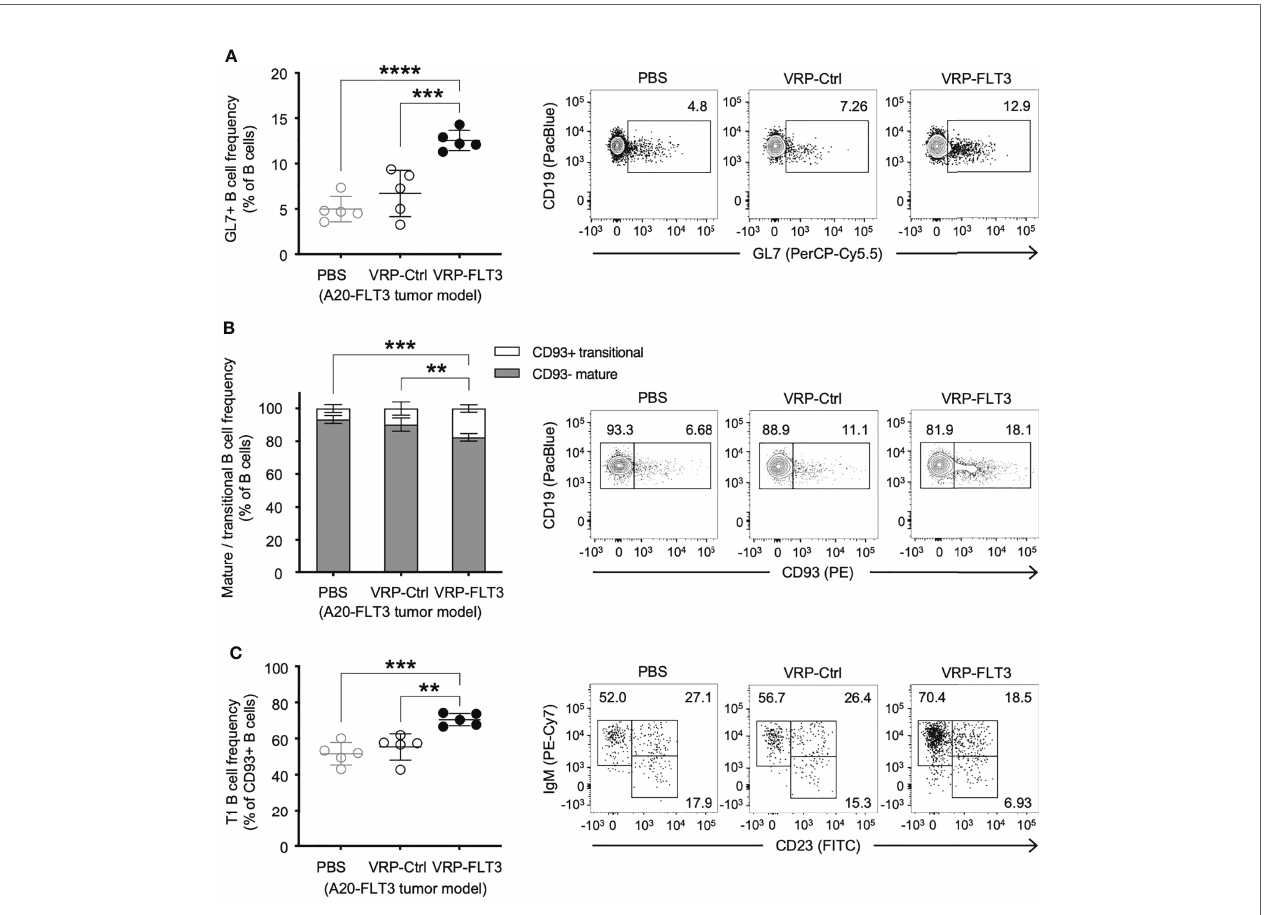
FIGURE 3 | VRP-FLT3 vaccination alters the composition of circulating B cells in a mouse lymphoma model. Mice challenged with A20-FLT3 tumor cells were vaccinated as described in Figure 1 . Blood samples harvested on days 14 were analyzed by fl ow cytometry for the frequency of (A) GL7 + B cells, (B) CD93 + mature B cells and CD93 – non-mature B cells, or (C) CD93 + IgM + CD23 – T1 B cells (n=5 per group). A representative sample of each group is shown in contour plot on the right. Bars represent the mean ± SD. Statistical signi fi cance was determined by one-way ANOVA, **P<0.01, ***P<0.001,